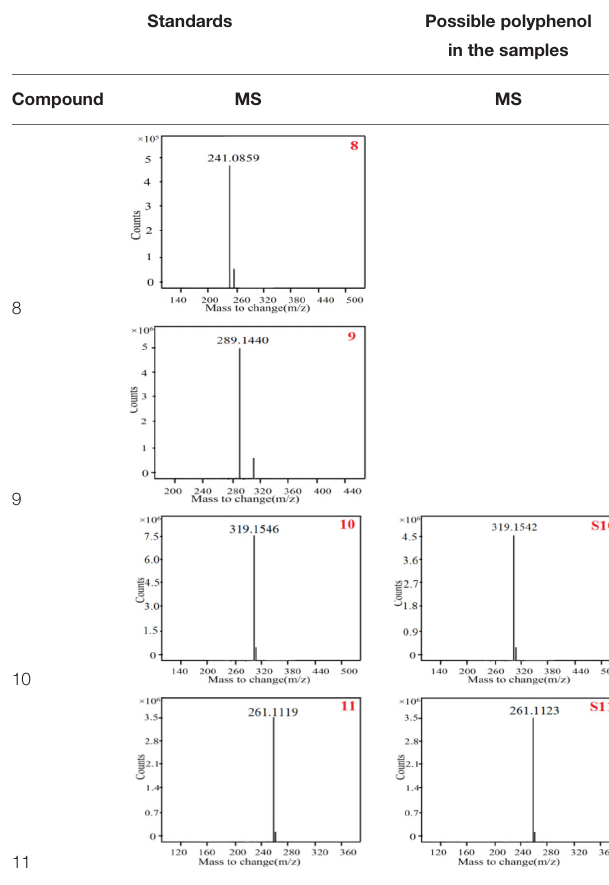
TABLE 2 | The MS spectrum of the standards and the possible polyphenols obtained by Q-TOF-MS